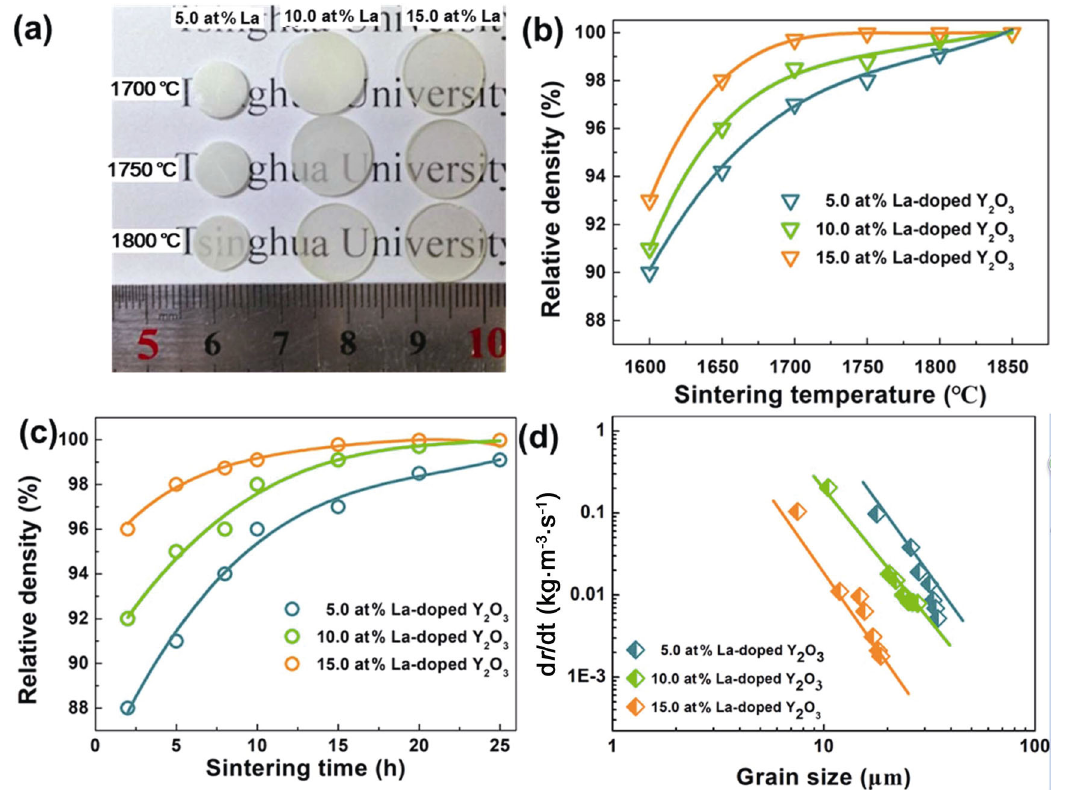
Fig. 3 (a) Optical pictures of La-doped Y 2 O 3 ceramics at the different sintering temperatures ( φ = 13 mm × 1.5 mm). (b) Relative density vs. sintering temperature, (c) relative density vs. sintering time, and (d) densification rate vs. grain size for La-doped Y 2 O 3 ceramics at a sintering temperature of 1750 ℃